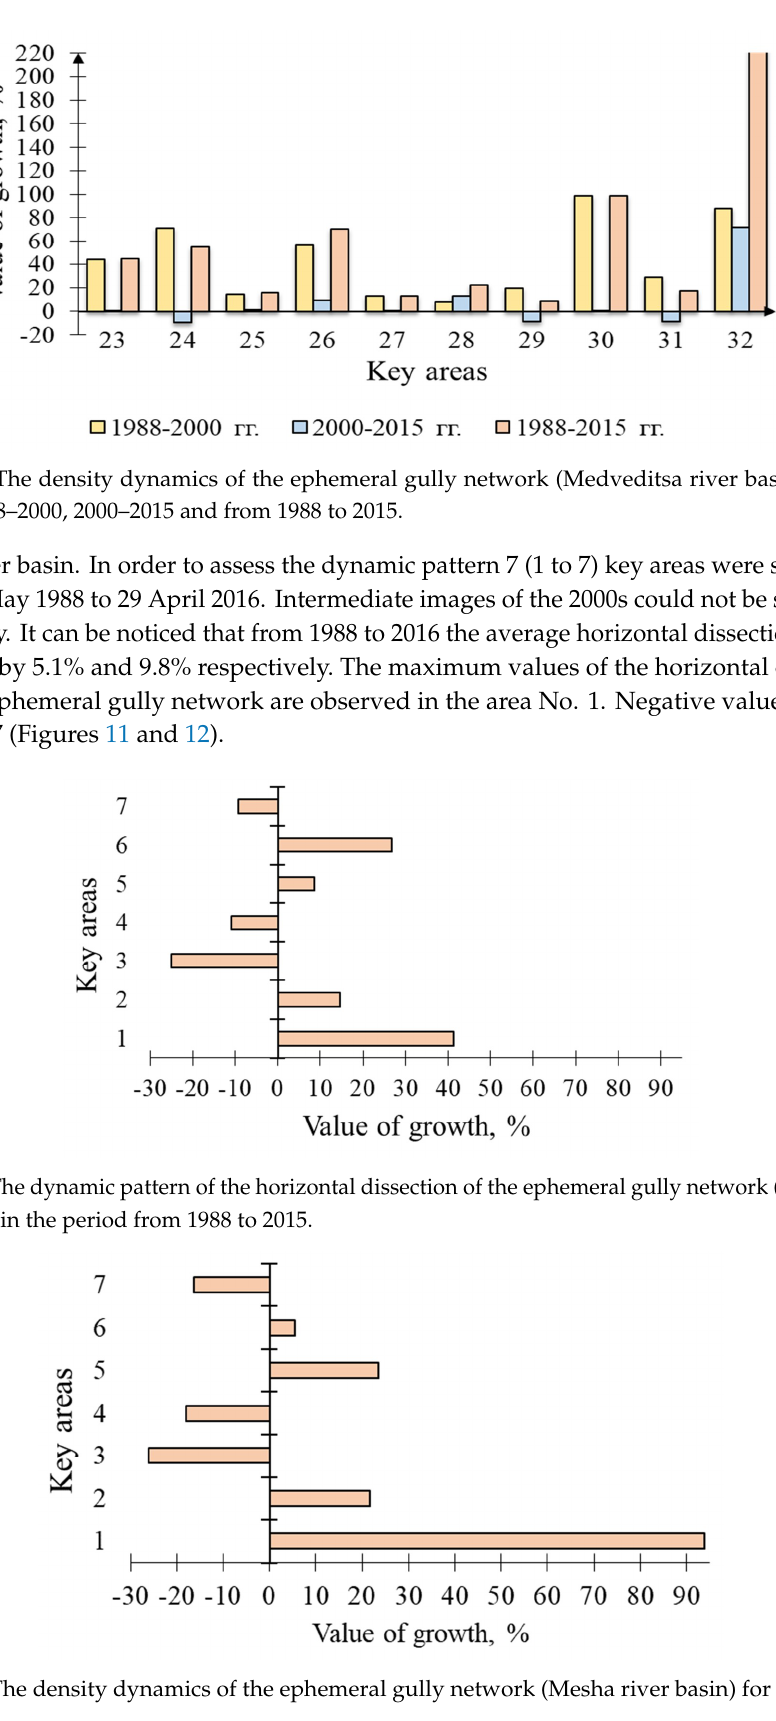
Figure 9. The dynamics of the horizontal dissection of the ephemeral gully network (Medveditsa river basin) for the periods 1988–2000, 2000–2015 and from 1988 to 2015.